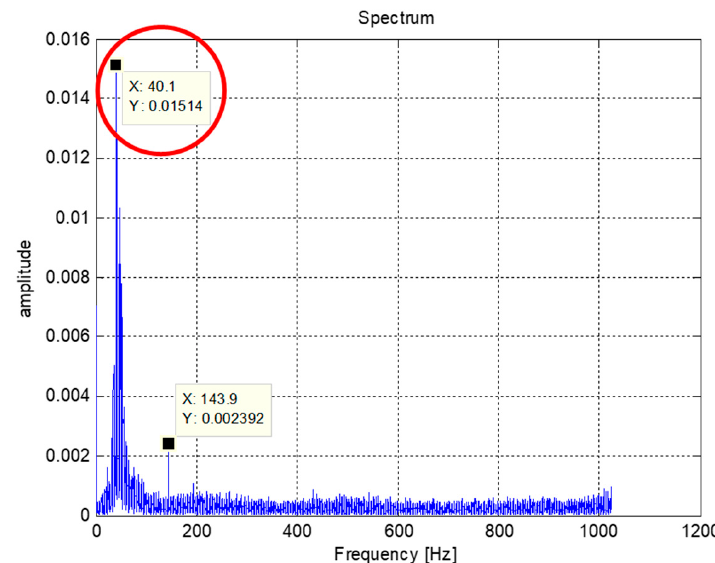
Figure 12. The frequency spectrum of the gear vibration signal; the meshing frequency at 40 Hz was observed.